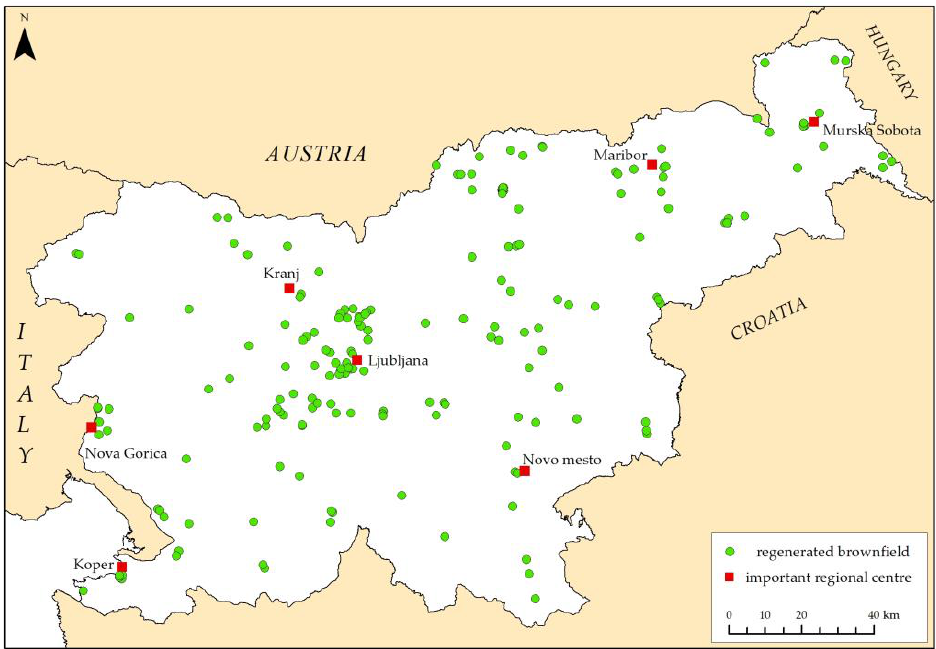
Figure 10. Spatial distribution of regenerated brownfields in Slovenia. Prepared by the authors [19].